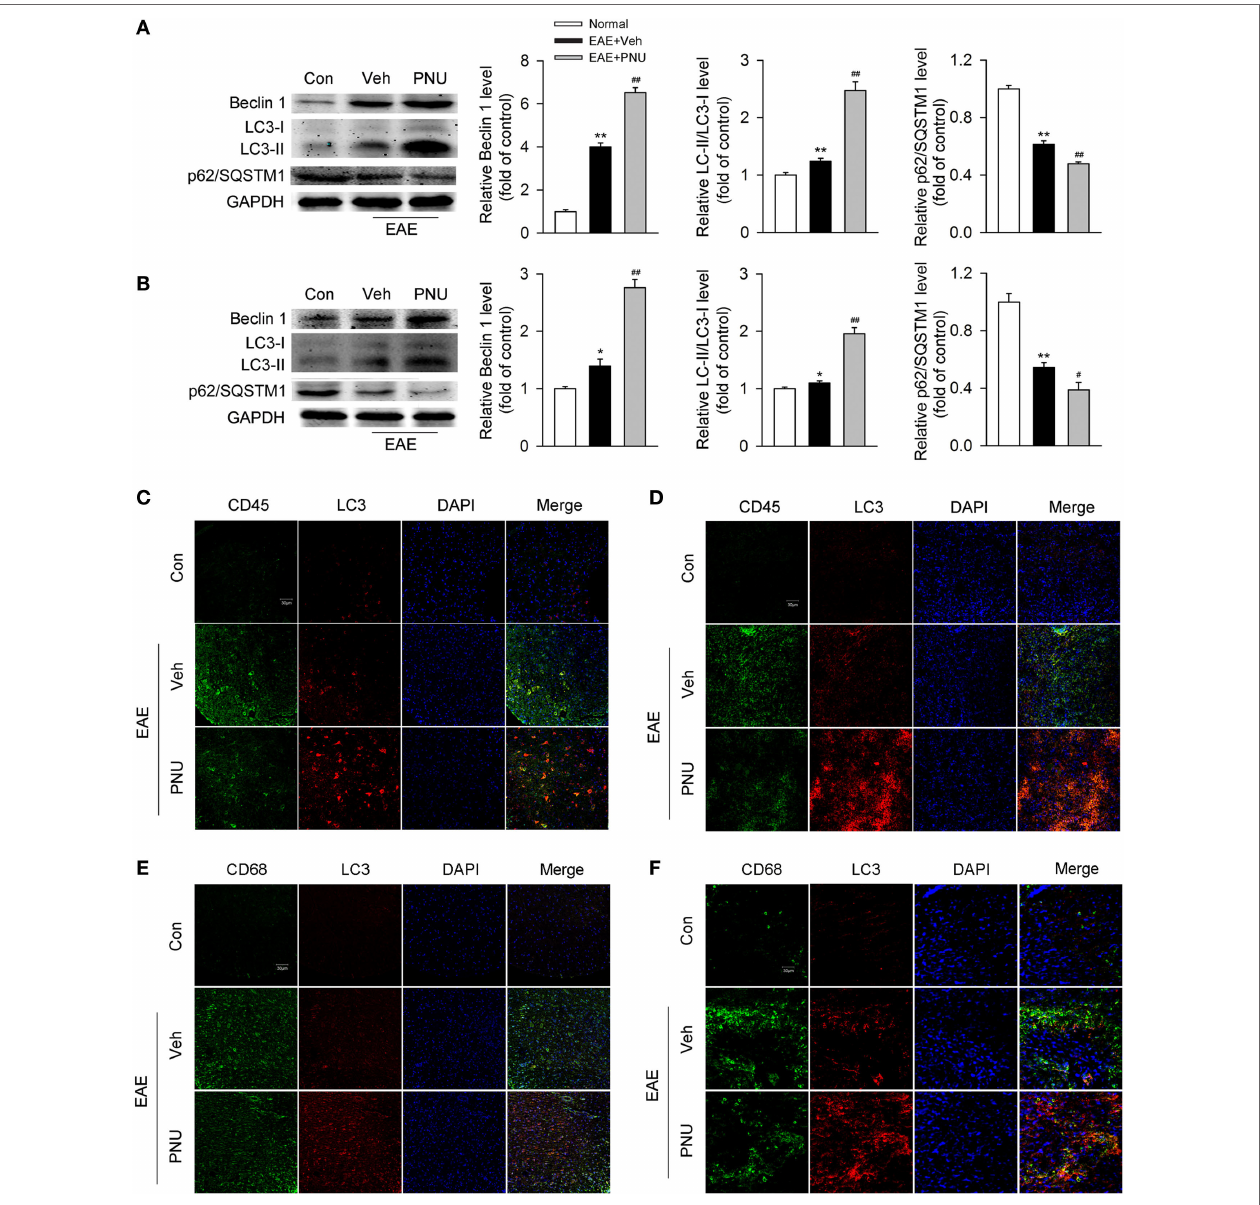
FigUre 2 | α 7nachr activation leads to the enhancement of monocyte/macrophage autophagy in spinal cord and spleen from experimental autoimmune encephalomyelitis (eae) mice . EAE mouse model was created and treated with PNU282987 (0.1 mg/kg, i.p.) or vehicle from day 3 postimmunization (PI) and were maintained on drug for the duration of the study. (a,B) Spinal cord and spleen were isolated from mice on day 17 PI, and then lysed with buffer. (a) Levels of autophagy-related proteins were detected by Western blotting in spinal cord. PNU282987-treated EAE mice significantly enhanced the levels of Beclin 1 and LC3-II/I ratio and reduced the level of p62/SQSTM1 compared with vehicle ( n = 6 per group). Quantitative analysis was conducted for the relative levels of Beclin 1, LC3-II/I ratio, and p62/SQSTM1. ** p < 0.01 vs Veh. (B) The same detections were conducted for the levels in spleen ( n = 6 per group). * P < 0.05 vs control; ** P < 0.01 vs control; # P < 0.05 vs vehicle; ## P < 0.01 vs vehicle. (c) Representative images of immunofluorescence microscopy of spinal cord paraffin- embedded sections for the staining of CD45, LC3, and DAPI. Scale bar, 30 µm. (D) Representative images of immunofluorescence microscopy of spleen paraffin- embedded sections for the staining of CD45, LC3, and DAPI. Scale bar, 30 µm. (e) Representative images of immunofluorescence microscopy of spinal cord paraffin-embedded sections for the staining of CD68, LC3, and DAPI. Scale bar, 30 µm. (F) Representative images of immunofluorescence microscopy of spleen paraffin-embedded sections for the staining of CD68, LC3, and DAPI. Scale bar, 30 µm. Veh, vehicle; PNU,